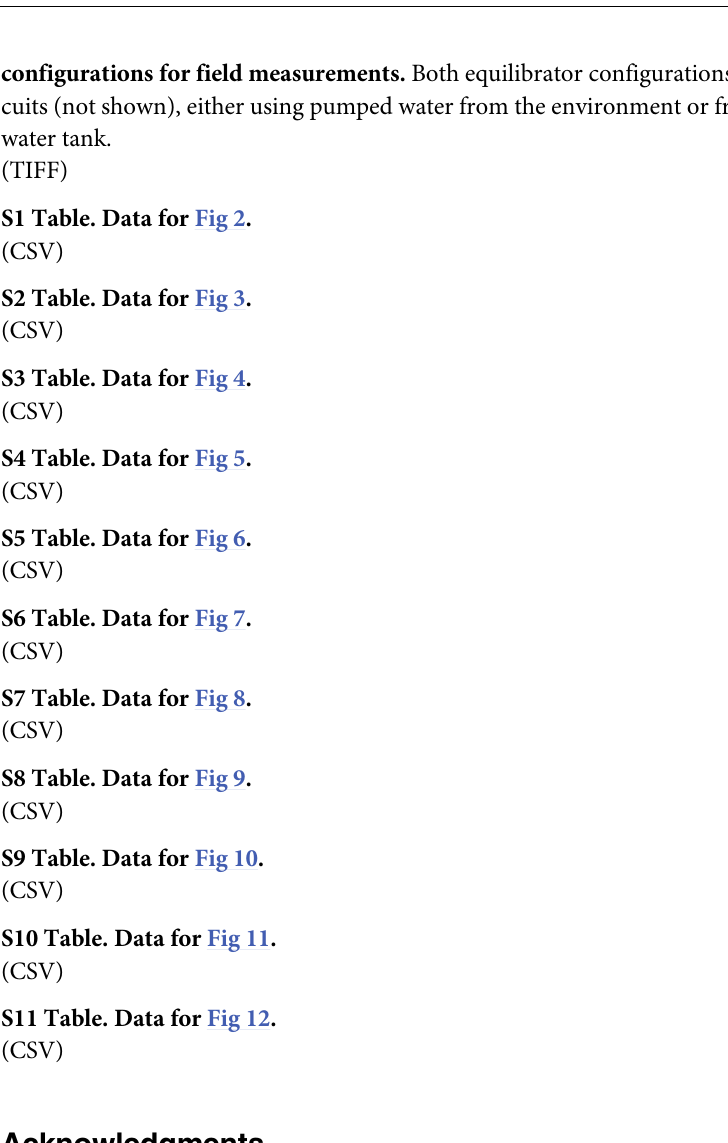
S11 Table. Data for Fig